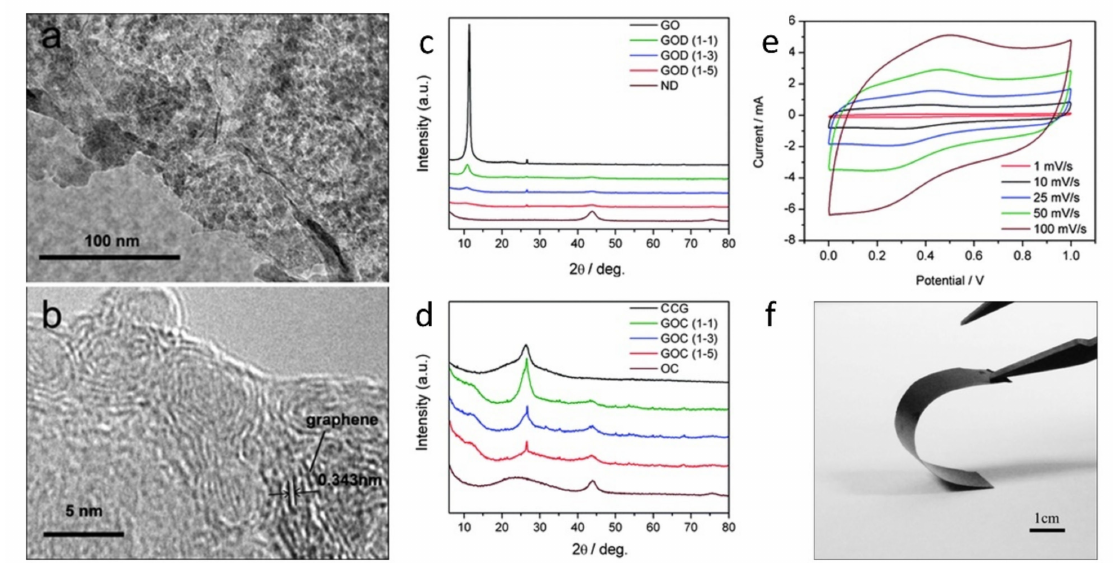
Figure 4. Example of GO—diamond composites for supercapacitors. Panels ( a ) and ( b ) present HRTEM images of the morphology at the nanoscale; panels ( c ) and ( d ) show typical XRD patterns of GO, ND particles, chemically converted GN films (CCG), onion-like carbon (OC), and mesoporous CCG/OC (GOC) composite films; panels ( e ) and ( f ) show cyclic voltammetry and photograph of the GOC film, respectively. Reprinted with permission from [139]. Copyright 2011 Royal Society of